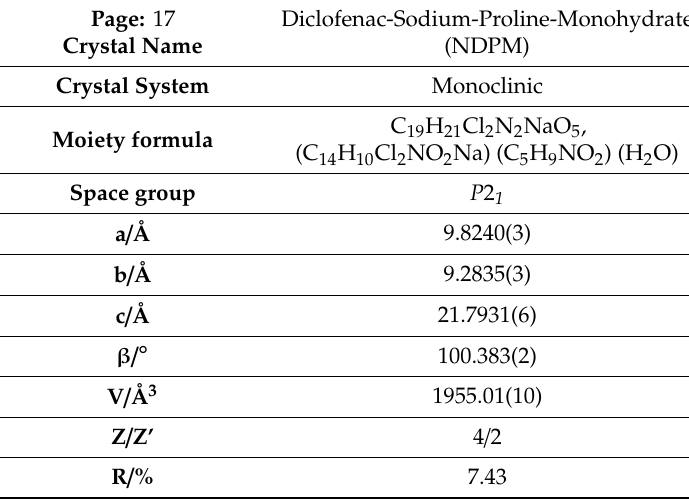
Table 2. Crystallographic data of NDPM.